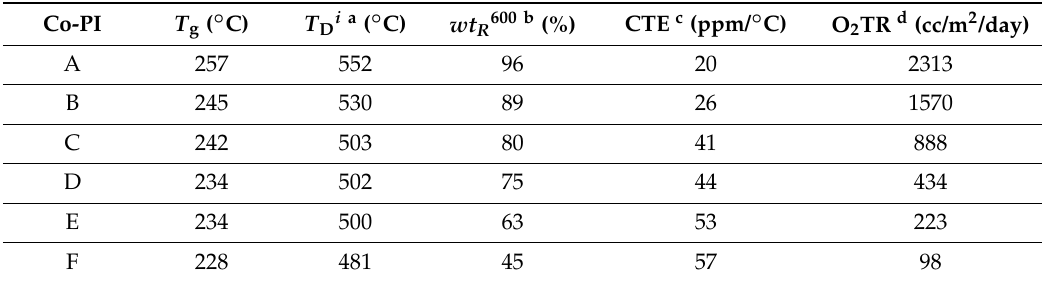
Table 3. Thermal properties of the Co-PI